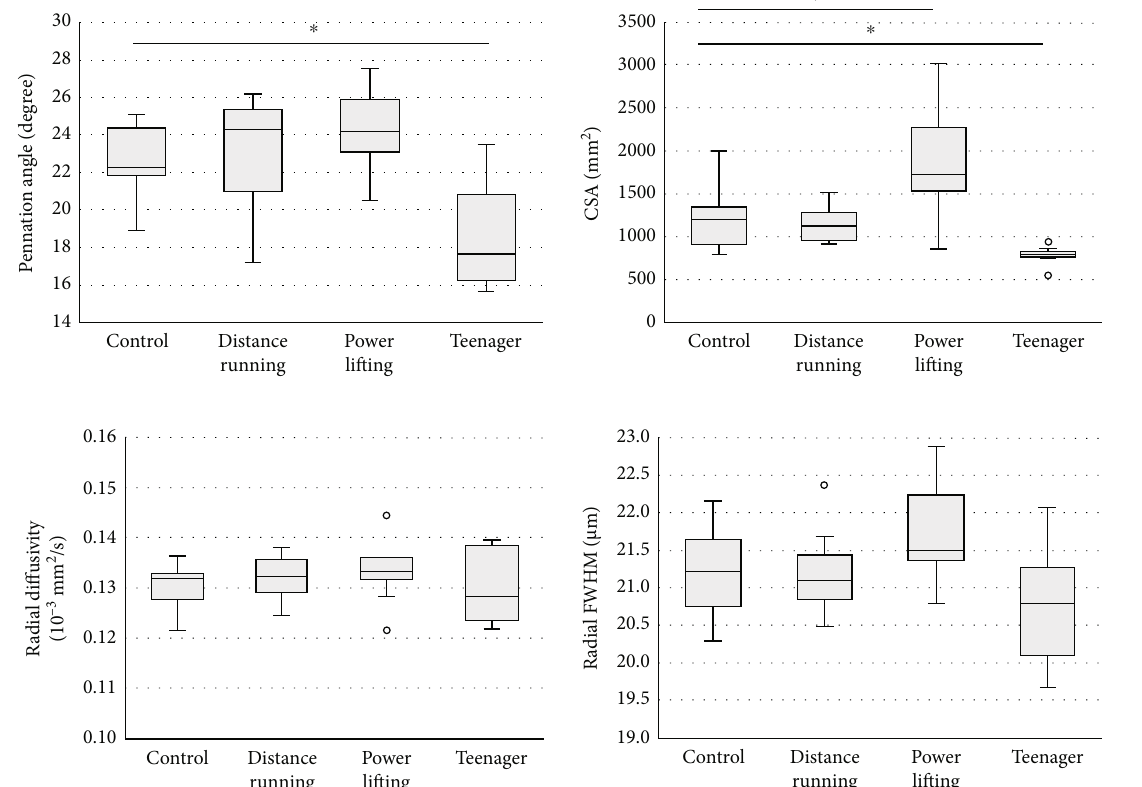
Figure 4: Quanti fi cation of magnetic resonance imaging parameters in the gastrocnemius muscle. Box and whisker plots: the bottom and top of the box are the fi rst and third quartiles. The band inside the box is the second quartile (median). The ends of the whiskers represent the minimum and maximum of all of the data. White circles are outliers. CSA: cross-sectional area; FWHM: full width at half maximum. ∗ P < 0 : 05 (Dunnett ’ s test;